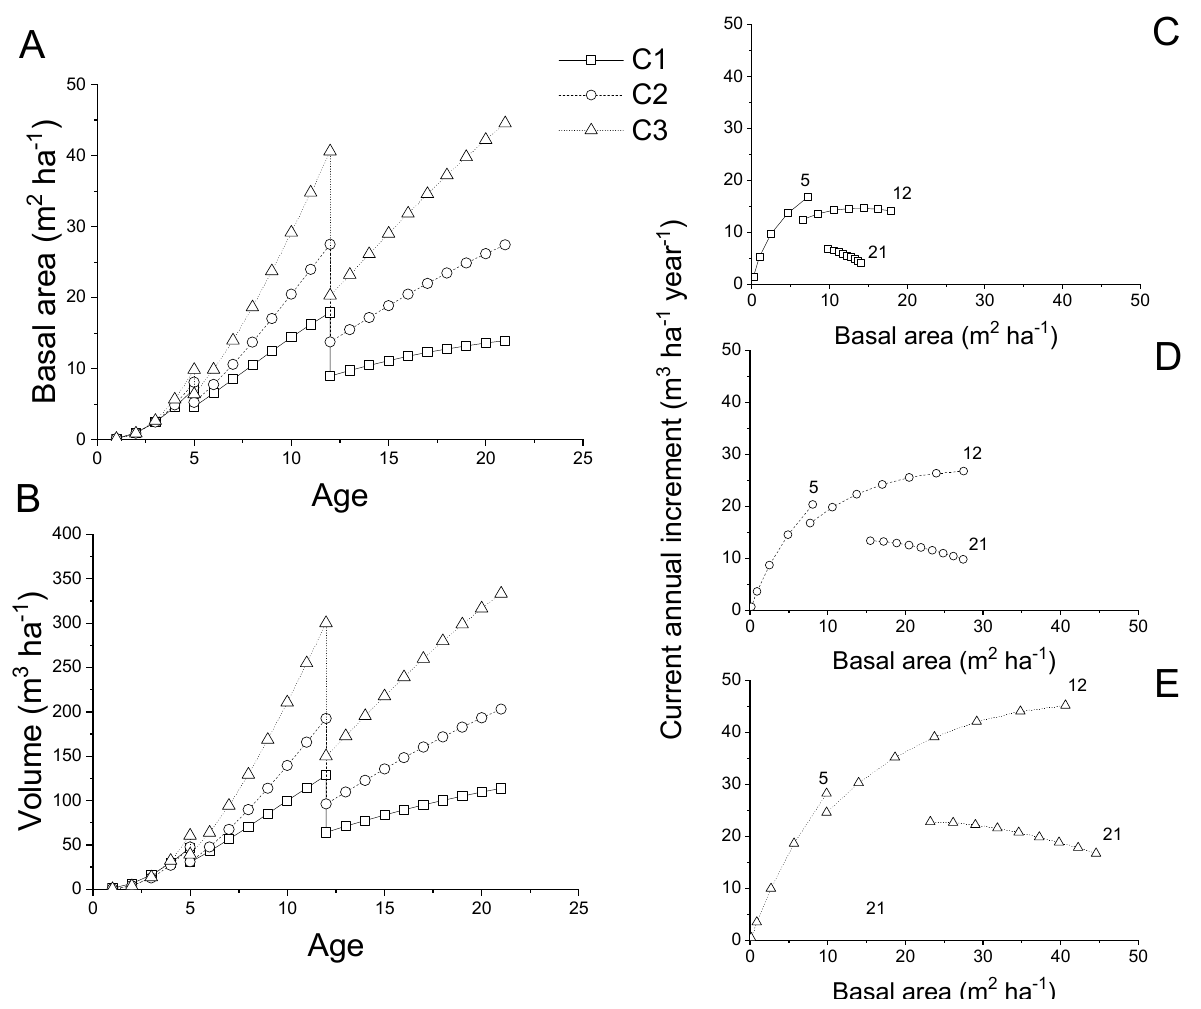
Figure 5. Pinus patula trees ( A ) basal area and ( B ) wood volume per hectare for three growth classes modeled for a 21-year-cutting cycle (1283 trees ha − 1 initial stand density; thinning applied in the 5th, and 12th year; 380 trees ha − 1 final stand density) and relationship of wood volume annual increment and basal area ( C – E ). ( C ) C1: 21.6, ( D ) C2: 30.3, and ( E ) C3: 38.7 cm DBH trees at cutting cycle. The site production capacity for each growth class was: 1.2 m 2 ha − 1 year − 1 and 9.3 m 3 ha − 1 year − 1 for C1 (Figure 5C); 2.1 m 2 ha − 1 year − 1 and 15 m 3 ha − 1 year − 1